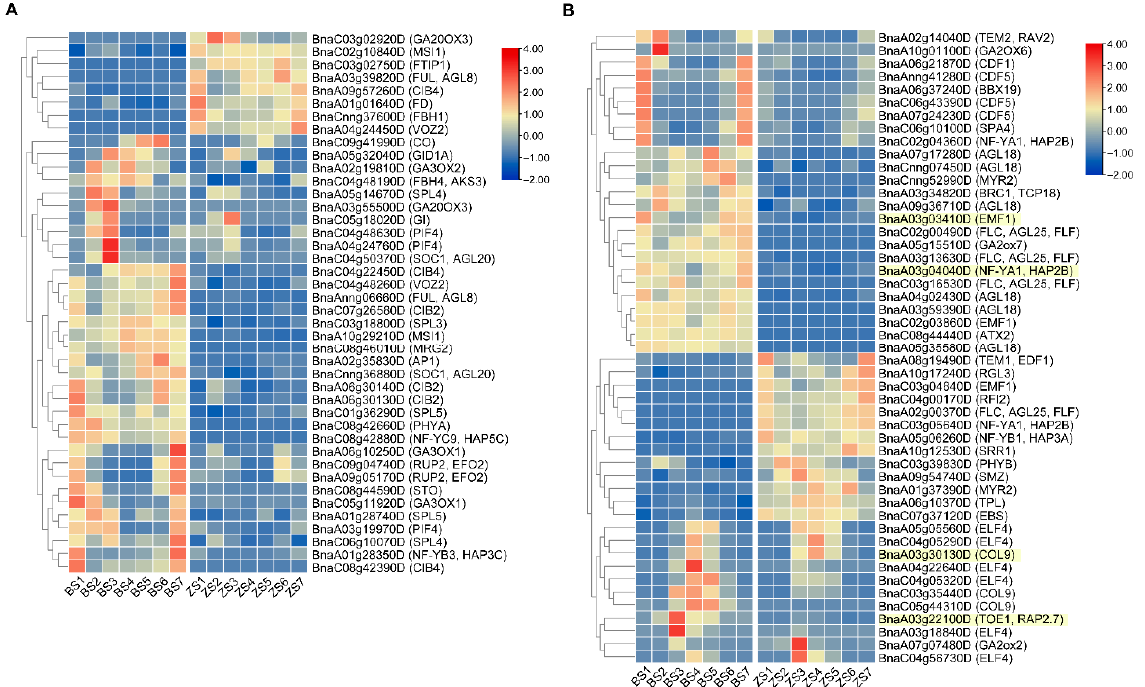
Figure 5. Heat maps of flowering-time genes differential expression in the photoperiod pathway. Positive and negative flowering-time regulators are indicated by ( A , B ), respectively. Gene names with yellow background are candidate genes in QTL intervals.